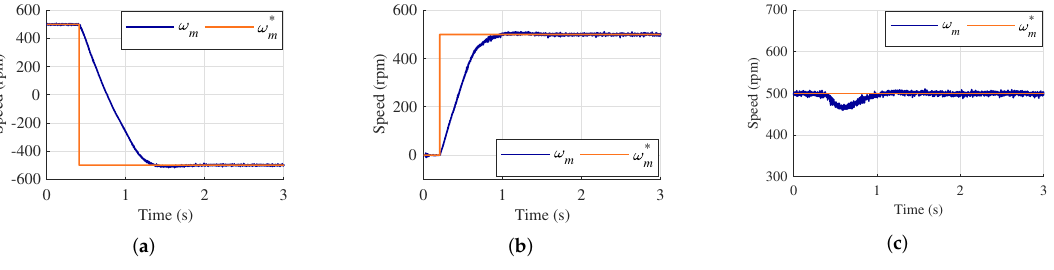
Figure 6. Rotor speed dynamic for the VSTLPC: ( a ) reversal test from − 500 rpm to 500 rpm, ( b ) speed step test from 0 rpm to 500 rpm, both tests with a load torque of 60%, and ( c ) torque step test from 0% to 60% of the nominal torque at 500